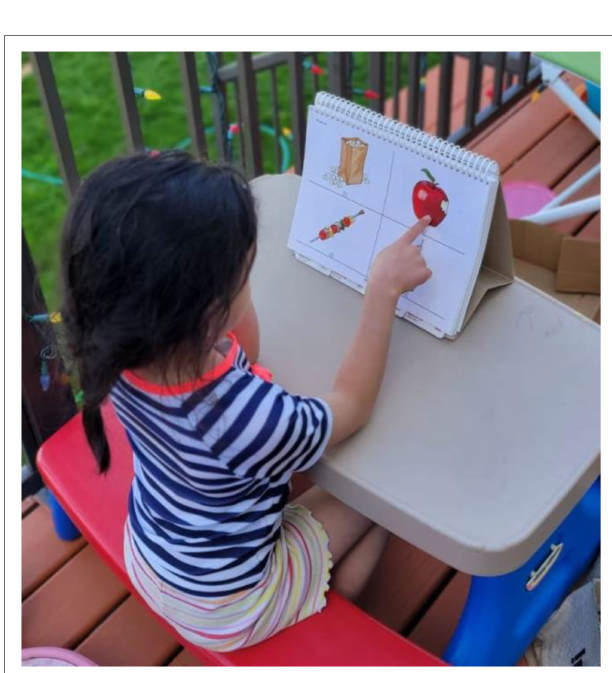
FIGURE 4 | Peabody Picture Vocabulary Test-III (PPVT). The child hears the word “apple” and correctly points at the object depicting